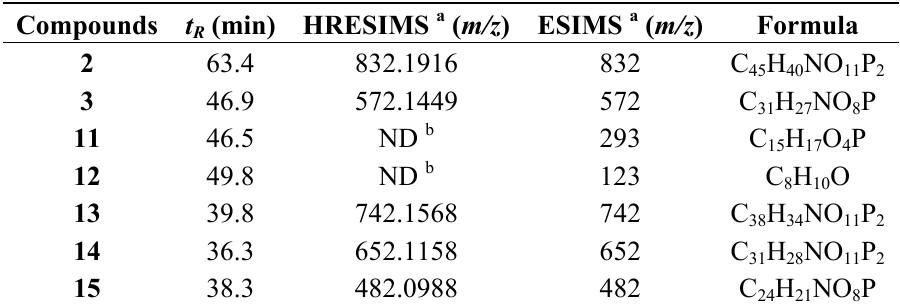
Table 1. LC-MS analyses of the reaction products.